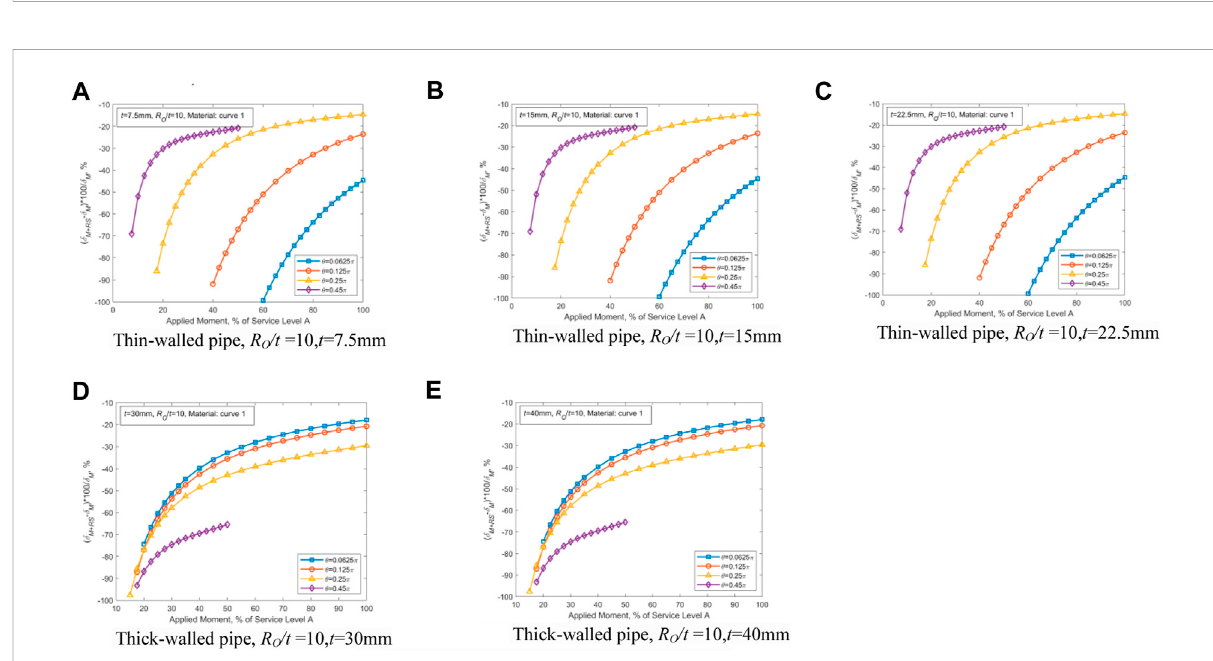
FIGURE 3 Effect of WRS on the external wall ’ s COD. (A) R o /t = 10, t = 7.5 mm. (B) R o /t = 10, t = 15 mm. (C) R o /t = 10, t = 22.5 mm. (D) R o /t = 10, t = 30 mm. (E) R o /t = 10, t = 40